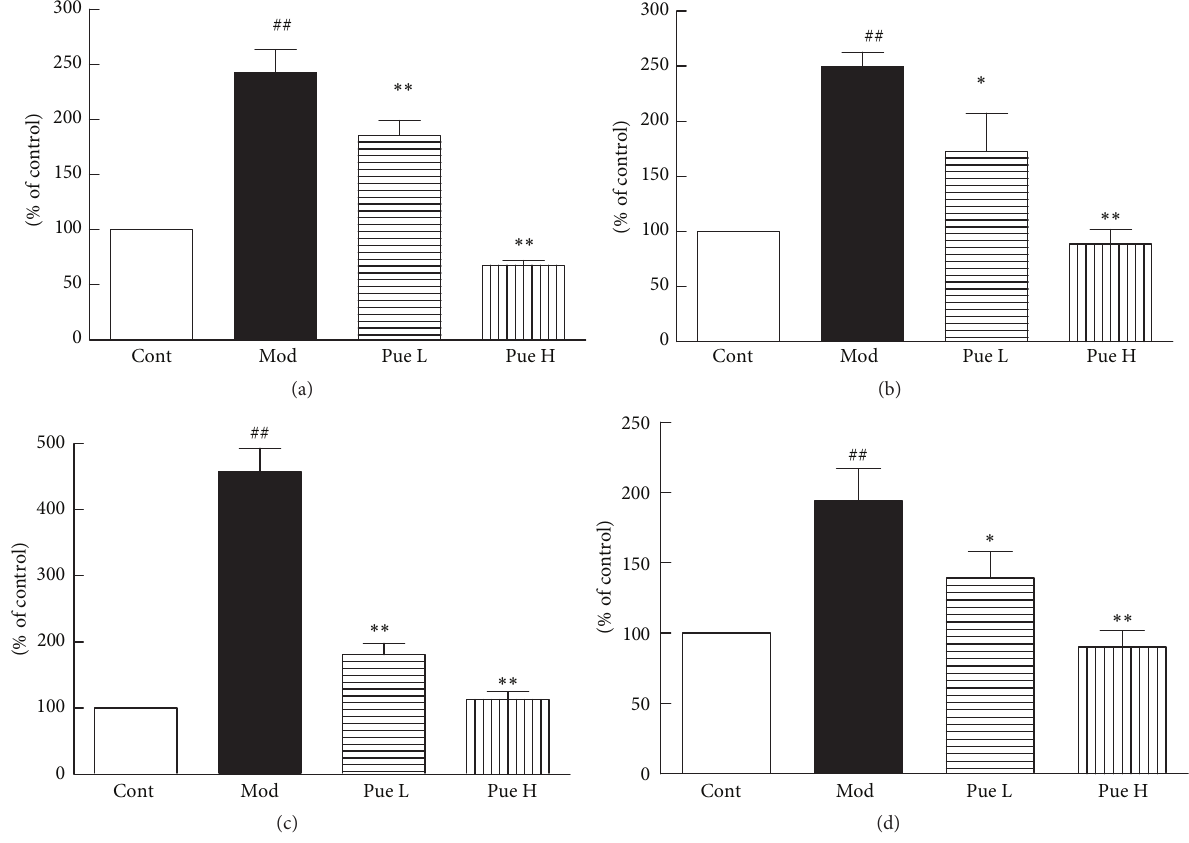
Figure 4: Effect of puerarin on mRNA expression of ICAM-1 (a), LOX-1 (b), NOX2 (c), and NOX4 (d) in the aorta of STZ-induced diabetic rats. ## 𝑝 < 0.01 versus Cont; ∗ 𝑝 < 0.05 and ∗∗ 𝑝 < 0.01 versus Mod. Cont, control group; Mod, diabetic model group; Pue L, low dosage of puerarin; Pue H, high dosage of